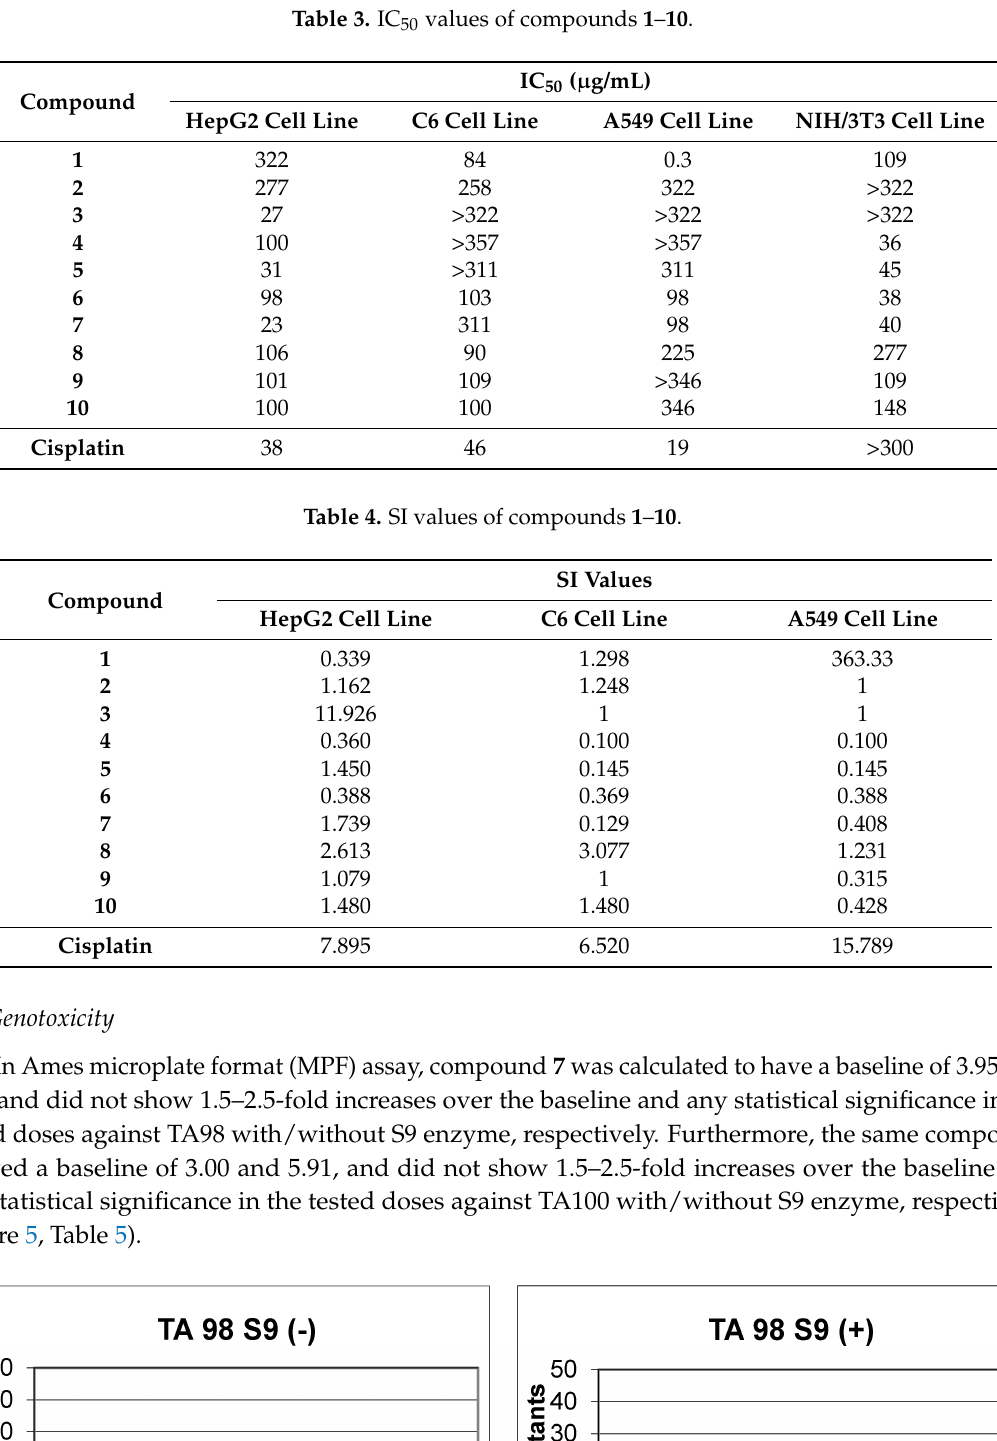
Table 3. IC 50 values of compounds 1 – 10 .